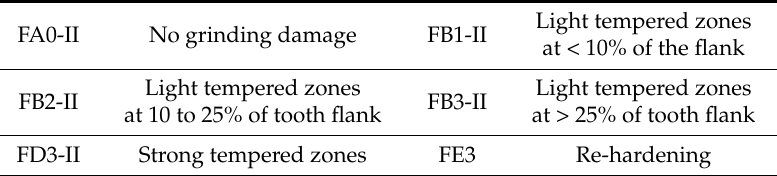
Table 10. Results of different types of calibration—without and with US parameters.